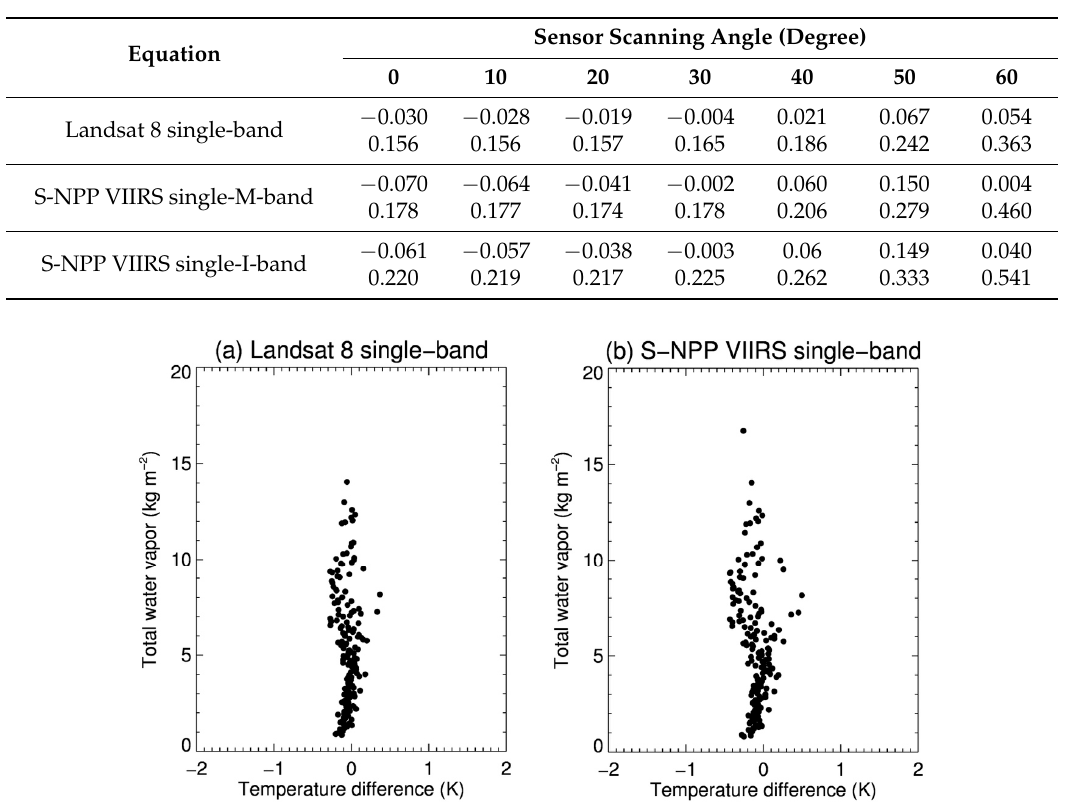
Figure 2. Relationship of the temperature difference between the retrieved and true ice surface temperature and total column water vapor for ( a ) Landsat 8 single-band algorithm, and ( b ) S-NPP VIIRS single-band for I5 band using Equation (3). Table 5. S-NPP VIIRS and Landsat 8 single-band ice surface temperature retrieval coefficients and the standard errors (in parenthesis) of the coefficients in the Arctic as in Equation Table 4. Bias (top row in a cell) and standard deviation (bottom row in a cell) of differences between single-band retrievals using Equation (3) and true surface temperatures for Landsat 8 and S-NPP VIIRS in the Arctic.